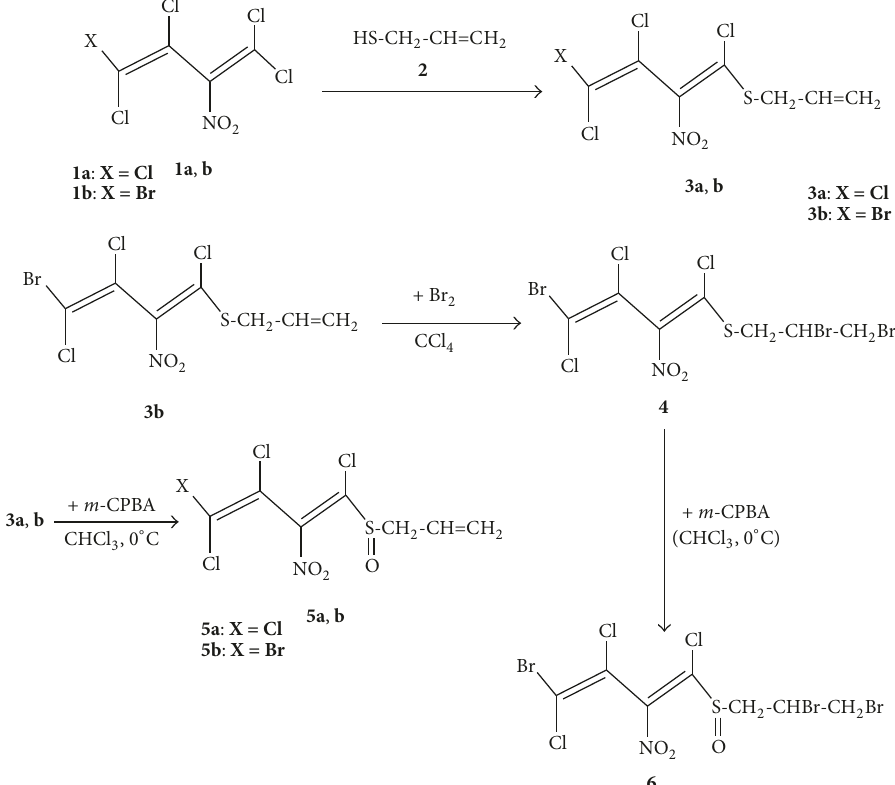
Scheme 1: Synthesis of S-substituted perhalonitrobuta-1,3-diene